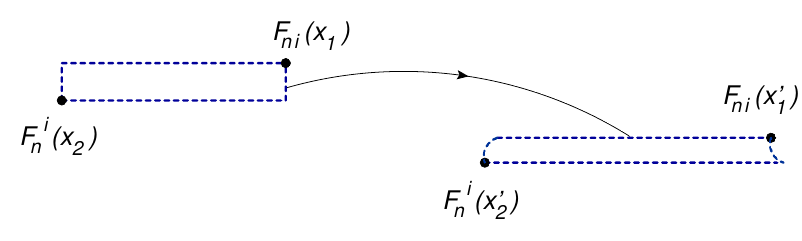
Figure 1 . Gluon \Wilson frame" operator.